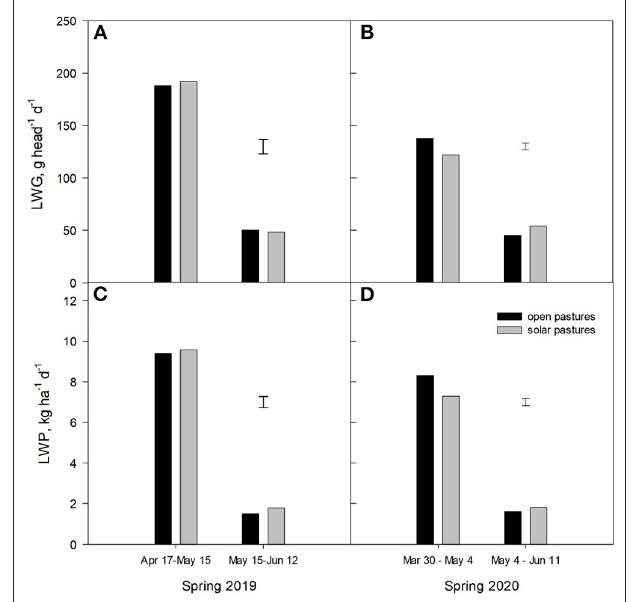
FIGURE 6 | Liveweight gains [LWG, g head − 1 d − 1 ; (A,B) ] and liveweight production [LWP, kg ha − 1 d − 1 ; (C,D) ] of lambs grazing under solar panels and open pastures in spring 2019 (A,C) and 2020 (B,D) . Bars represent SEM.